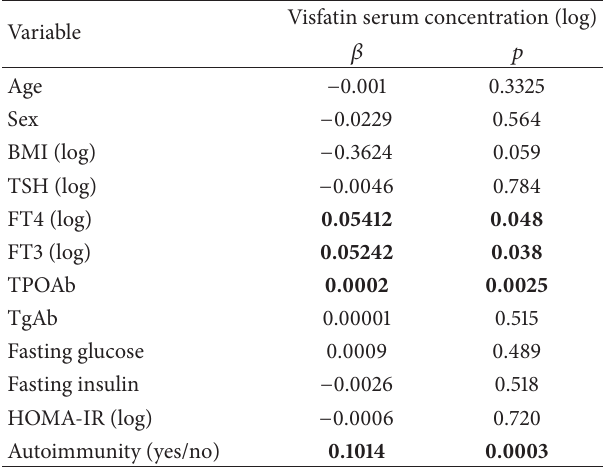
Table 2: Simple linear regression analysis using visfatin serum concentration as dependent